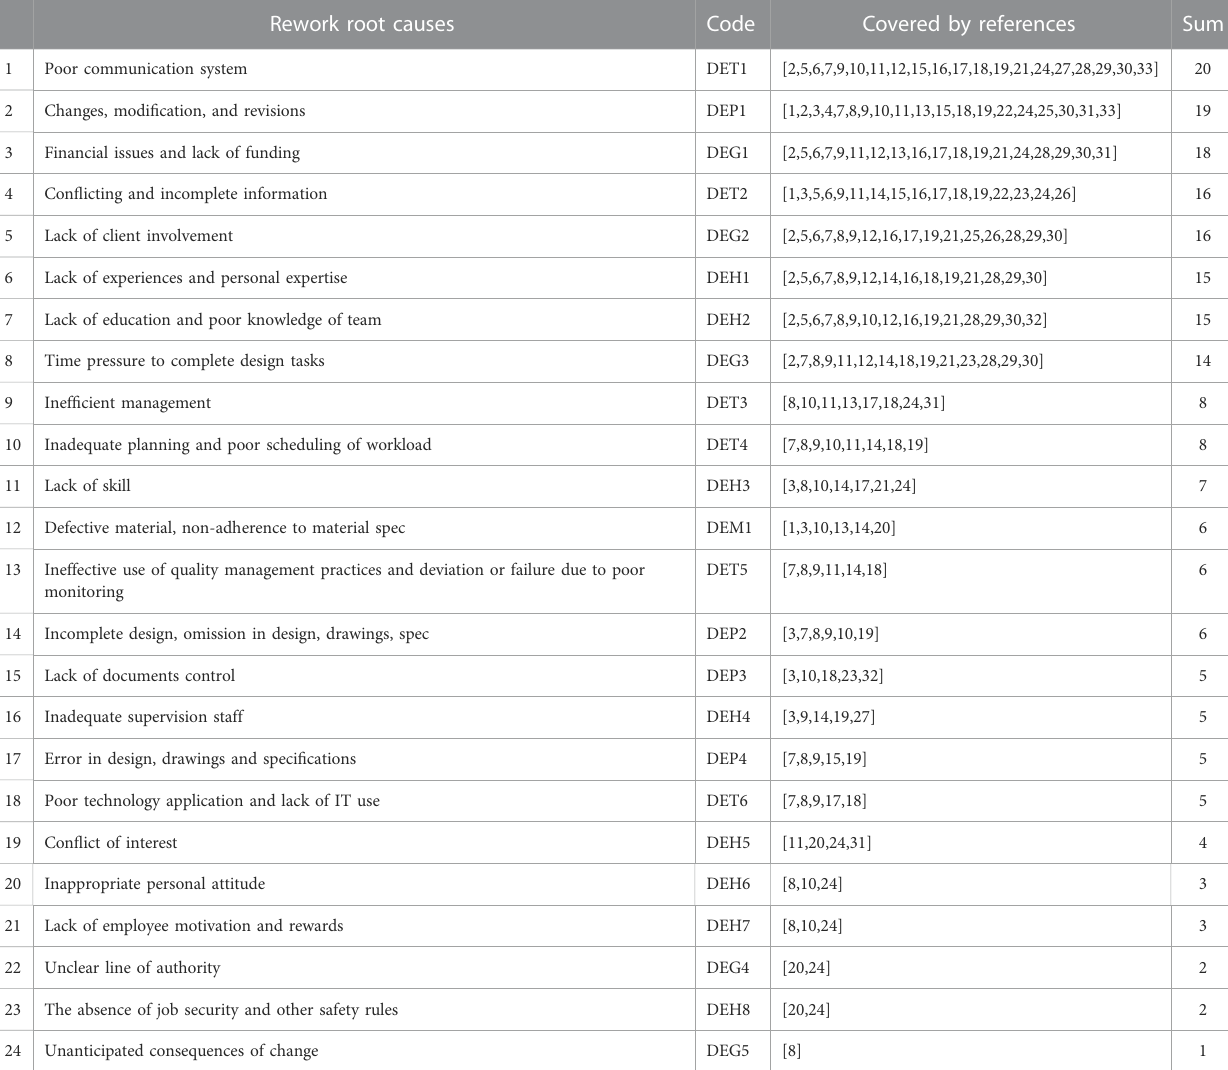
TABLE 2 Rework causes classi fi cation in design stage — liable to the client-side of the